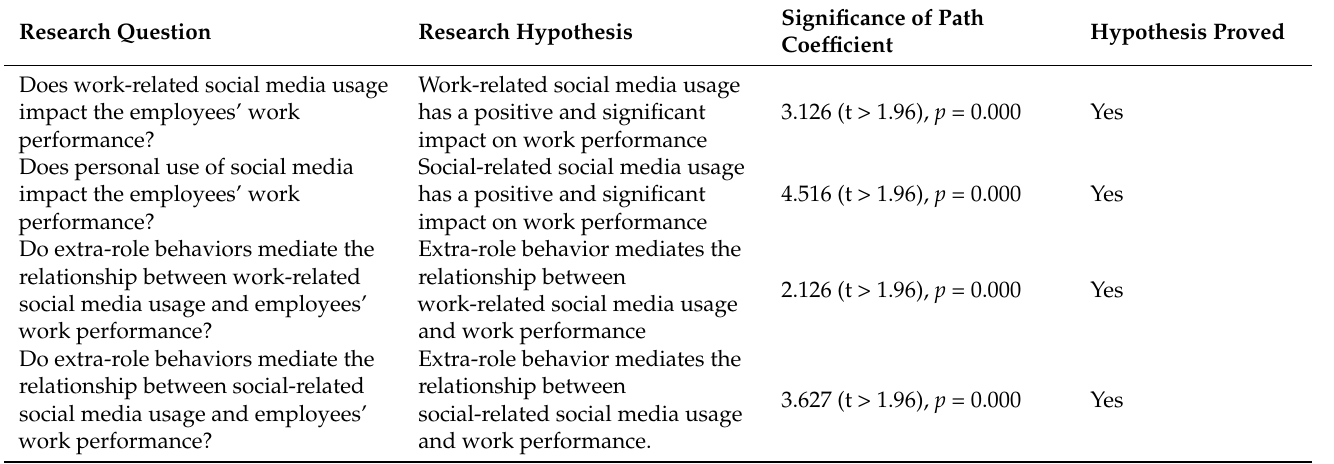
Table 7. Summary of research questions, hypothesis, and significance of path coefficients.